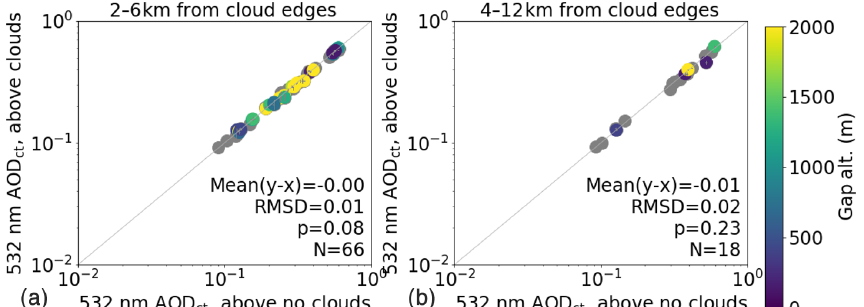
Figure 5. (a) The local-scale near-synchronous samples of the AOD above cloud top height. Each marker represents the mean over the cloudy and clear sides of a cloud edge, with each 2–6km from the edge. The bars indicate the standard deviation of the measurements in each side, with almost all of them too short to be discernible. (b) Same as (a) except for the horizontal separation of 4–12km. Table 2. The mean values and the statistics on the cloudy–clear